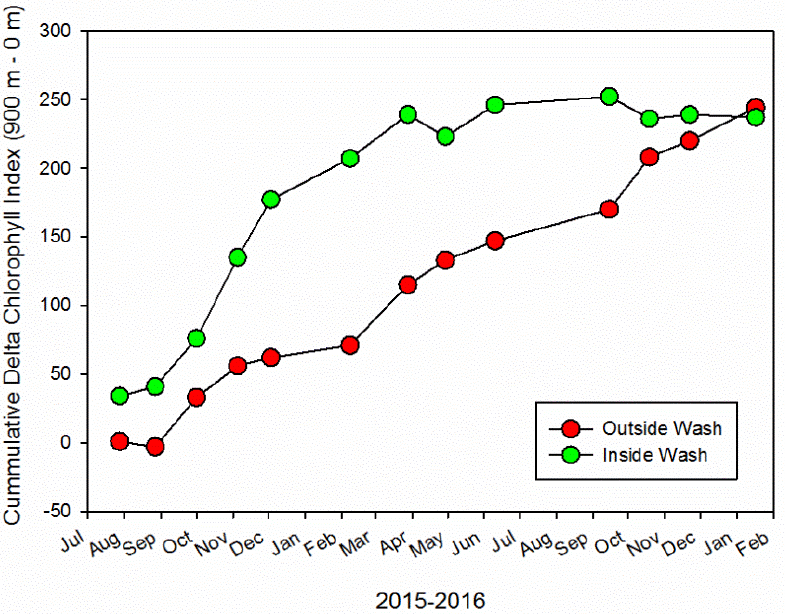
Figure 6. Cumulative delta chlorophyll index values measured on creosote plants at the end of the 900 m gradient minus values at the beginning of the 900 m gradient (next to tower AF), significantly different at the p < 0.001 level.